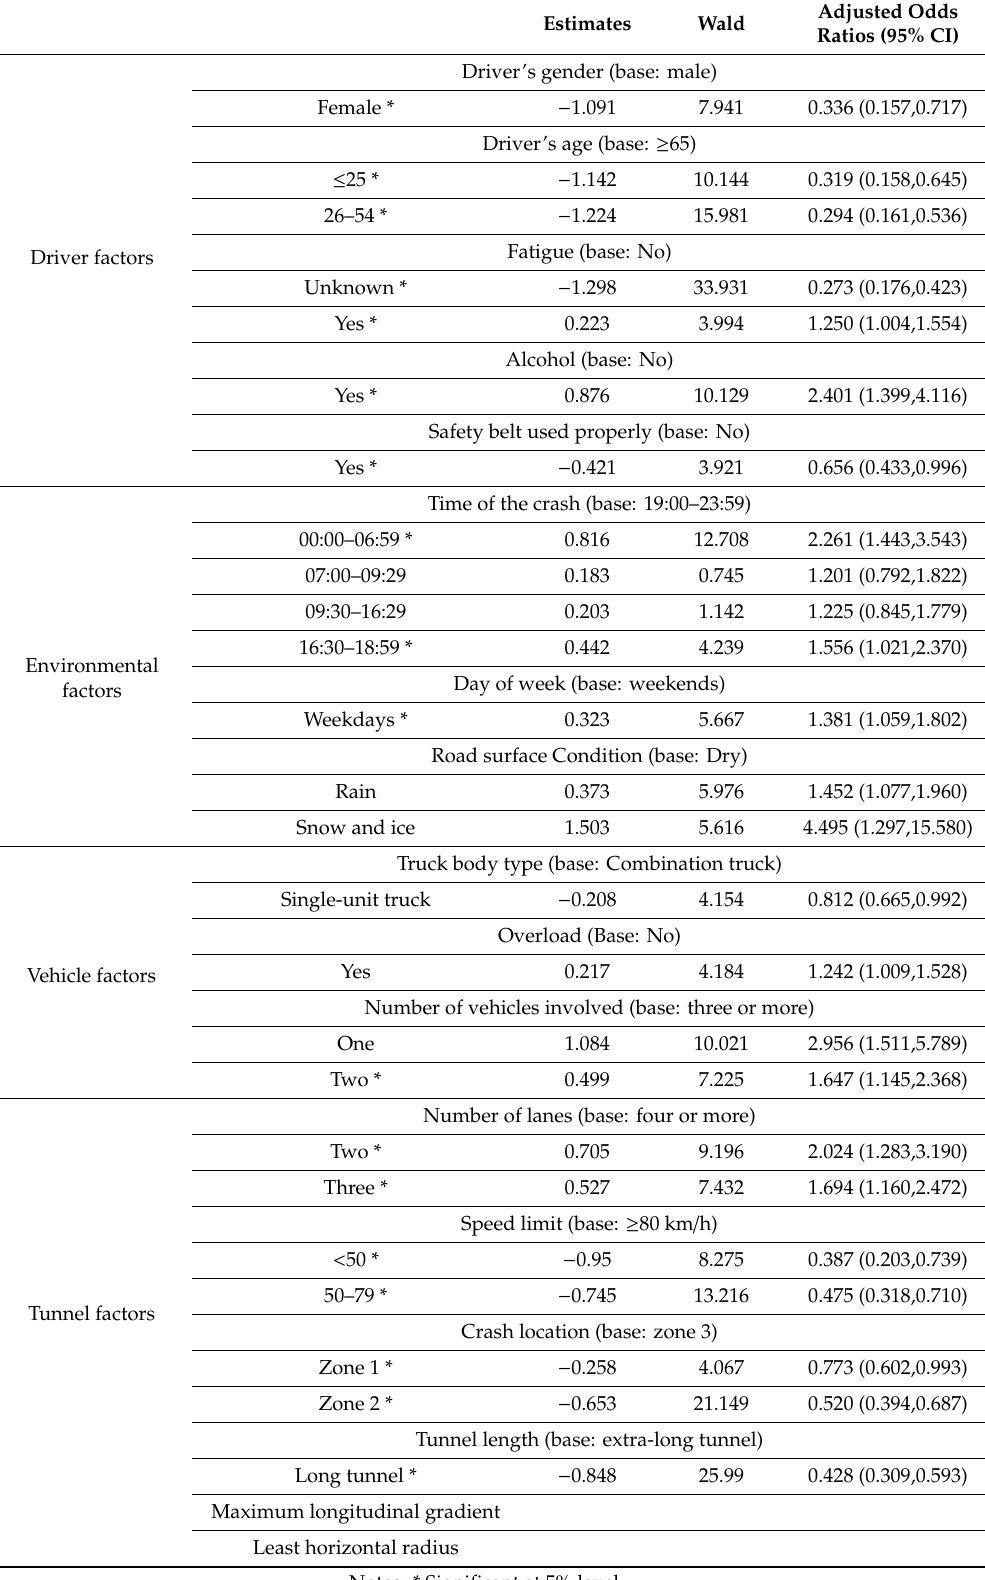
Table 5. Results of